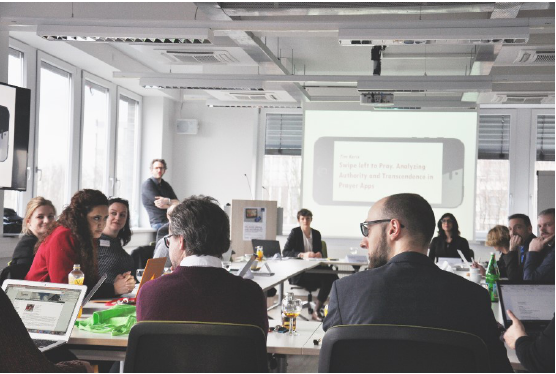
Figure 3 Over the course of its existence, the KHK held a total of 254 international workshops and